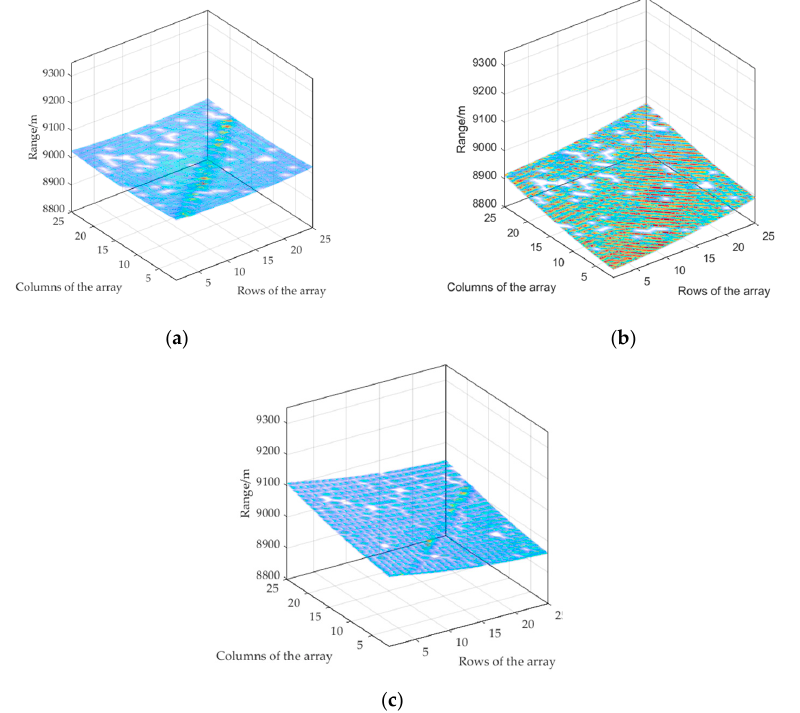
Figure 8. Separation result of sparse array range profile. ( a ) The range profile of target 1 of sparse array. ( b ) The range profile of target 2 of sparse array. ( c ) The range profile of target 3 of sparse array.